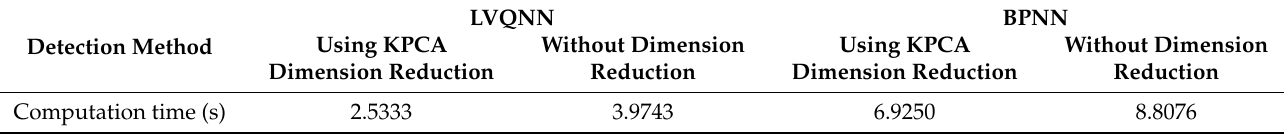
Table 5. Recognition time of different detection